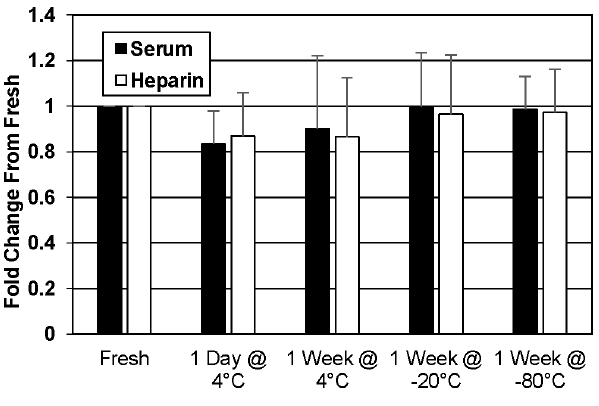
Figure 7. Comparison of SP-D values in samples stored in various conditions. Serum and heparin plasma samples collected during a single draw were either analyzed fresh or aliquoted and stored at 4 u C, 2 20 u C, or 2 80 u